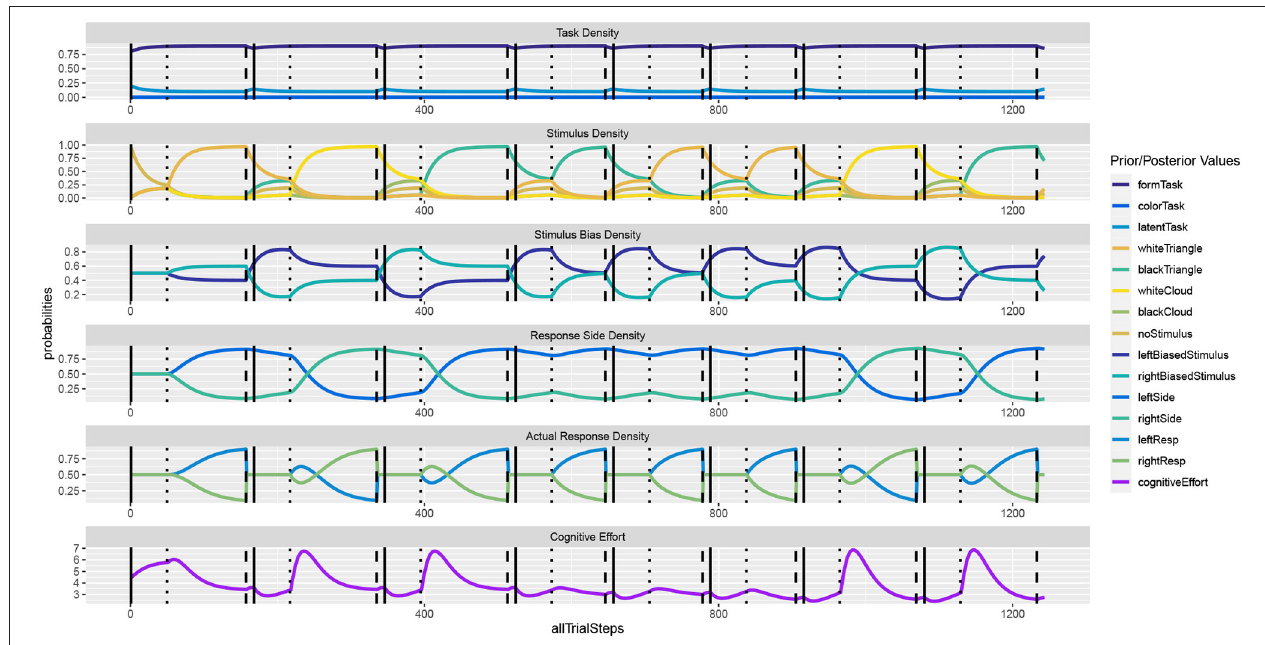
FIGURE 2 | In the Simon effect , the response dynamics are influenced by the side of the stimulus, besides the actual stimulus identity. The dynamics clearly show how REPI gets ready for the task once the fixation cross is shown (vertical solid bars). Once the imperative stimulus is shown (vertical dotted bars), response inference is activated and evidence for either response side accumulates. The response is triggered when a particular response threshold (set to 0.9) is reached (vertical dashed